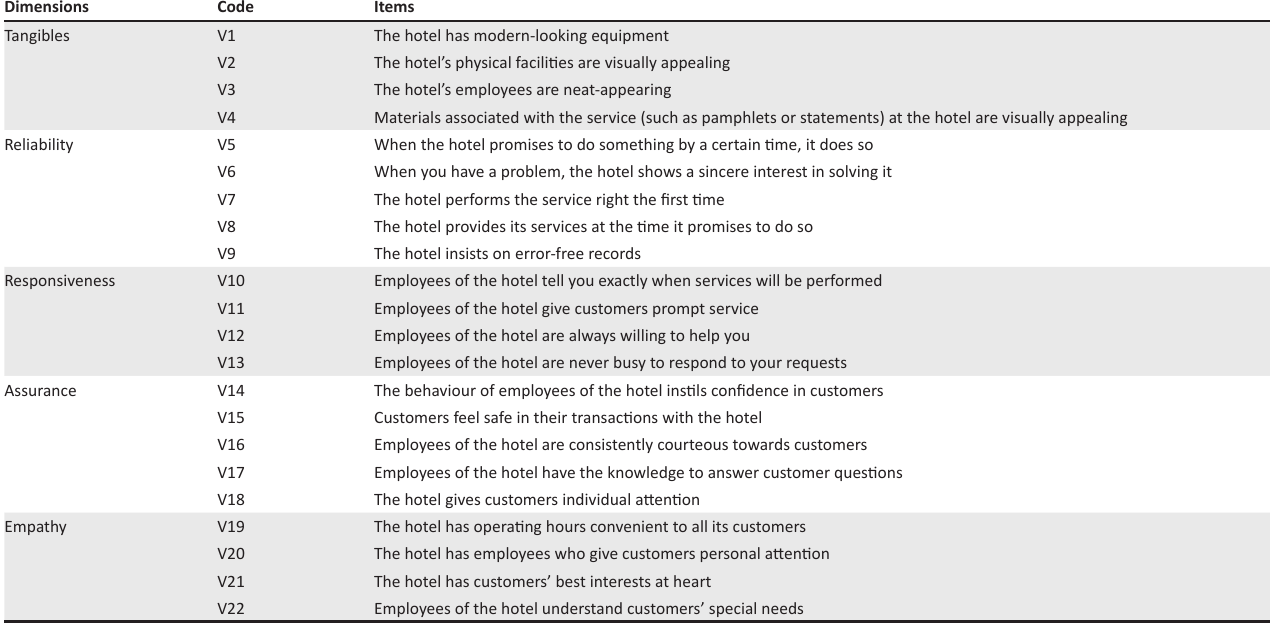
TABLE 1: Hotel Service Quality measurement attributes and dimensions.